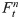
Evaluation on the symmetry of accuracy measures to over-estimates and under-estimates.A: Synthetic time series data where Yt is the target series and Ftn are forecasts. Ft1 makes a 10% over-estimate to all observations of Yt, while Ft2 makes a 10% under-estimate. B: Results of symmetric evaluation, which shows UMBRAE and all other accuracy measures except sMAPE are symmetric.